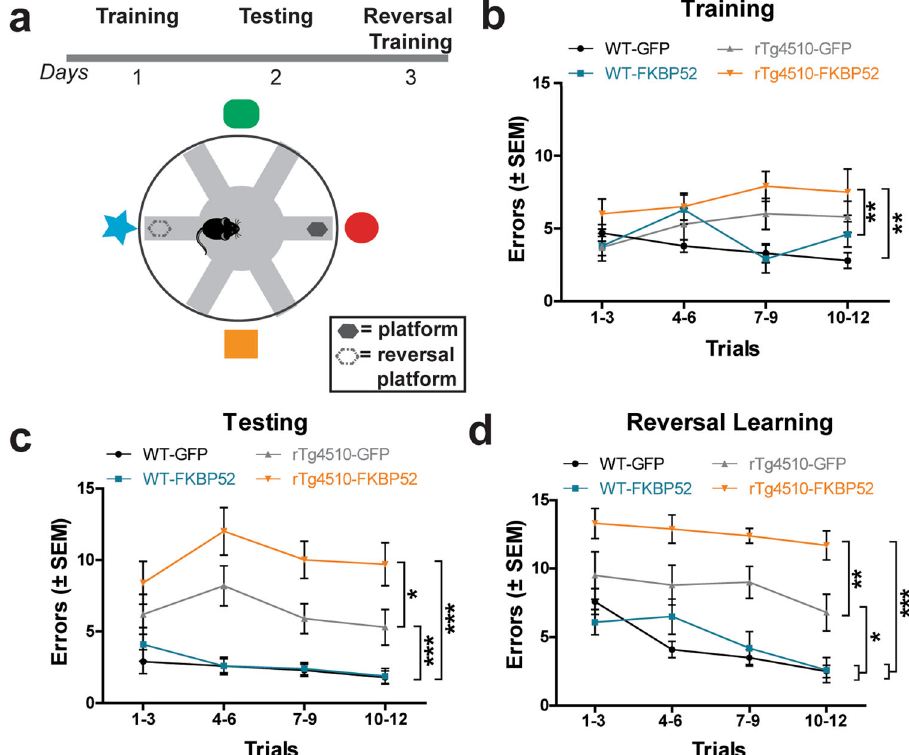
Fig. 4 Overexpression of FKBP52 impairs spatial learning and working memory in rTg4510 mice. a Schematic of experimental protocol for the radial-arm water maze (RAWM) test which was used to evaluate spatial learning and working memory. The total number of errors to locate the platform was counted as the performance for each day. Each data point represents an average of 3 – 60 s trials. b On day 1, spatial learning (training), mice were trained for 12 trails alternating between visible and hidden platform. c On day 2, spatial memory (testing), platform remained hidden during all trials. d On day 3, for the reversal learning, the goal arm (reversal platform) was in the opposite arm to day 1. We used a total of 18 rTg4510 mice [ n = 8 for AAV9-GFP; n = 10 for AAV9-FKBP52] and 19 wild-type mice [ n = 10 for AAV9-GFP; n = 9 for AAV9- FKBP52] for this test. Data were analyzed by repeated measures two-way ANOVA followed by Bonferroni post hoc test (* p < 0.05, ** p < 0.01, *** p < 0.001). Data are shown in standard error of the mean (±SEM). AAV9 adeno-associated virus serotype 9, WT wild-type, GFP green fl uorescent